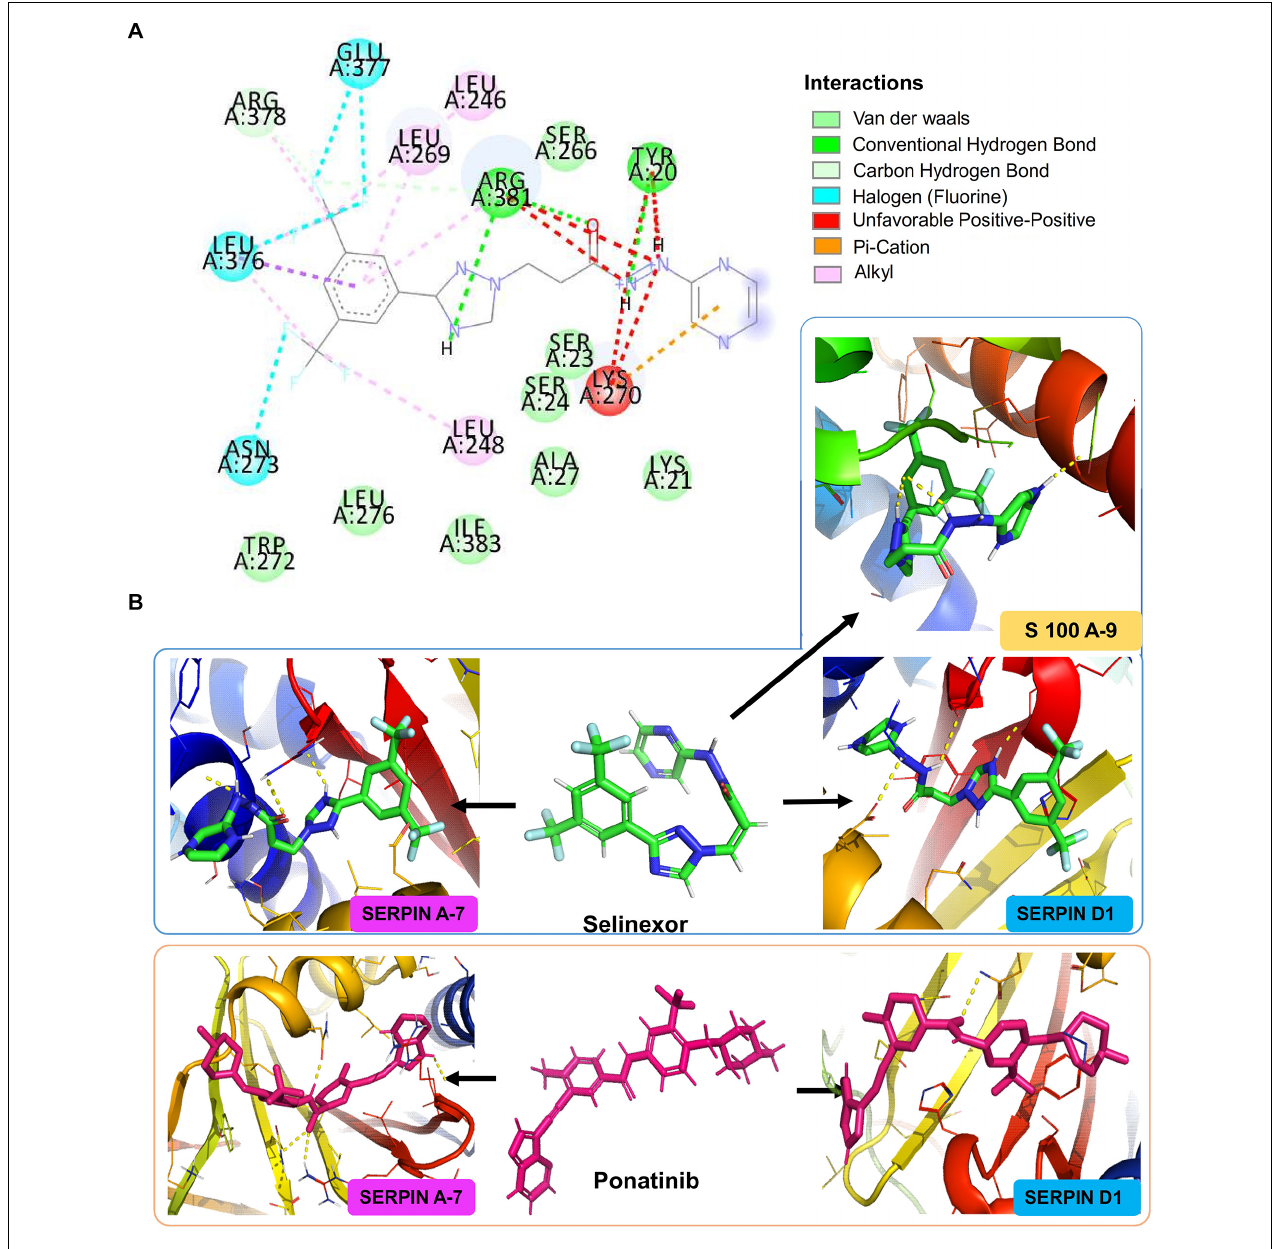
FIGURE 5 | In silico molecular docking of small molecules against upregulated proteins from different stages of COVID-19 infection. Figure showing the docking results of three different target proteins SERPINA7 (non-severe vs. severe), SERPIND1 (non-severe vs. severe), and S100A9 (COVID-19 positive vs. COVID-19 negative) with two FDA-approved drugs selinexor and ponatinib. (A) The predicted 2D interaction map of selinexor with SERPINA7. (B) The 3D representation of predicted binding pockets of the two drugs to the targeted proteins. The binding affinity of selinexor SERPINA7 is -9.3 kcal/mol, SERPIND1 is -8.7 kcal/mol of binding affinity, and S100A9 is -7.5 kcal/mol. Drug ponatinib binds with SERPINA7 with -9.3 kcal/mol of binding affinity and with SERPIND1 with -8.4 kcal/mol binding